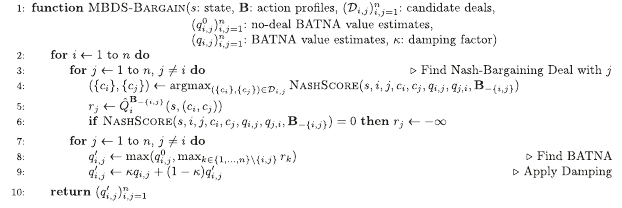
Algorithm 4 BATNA Update by Internal Dynamic Bargaining